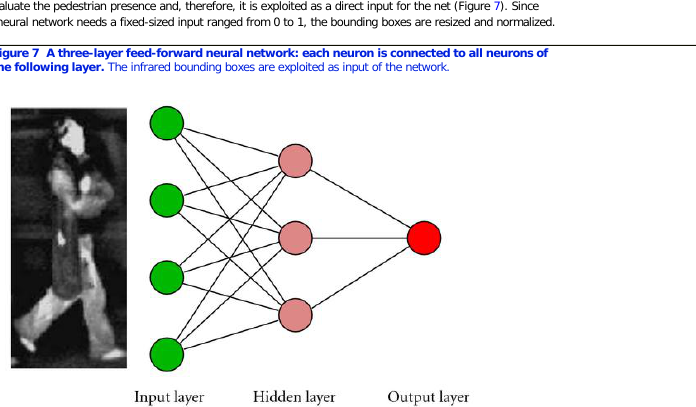
Figure 7 A three-layer feed-forward neural network: each neuron is connected to all neurons of the following layer. The infrared bounding boxes are exploited as input of the